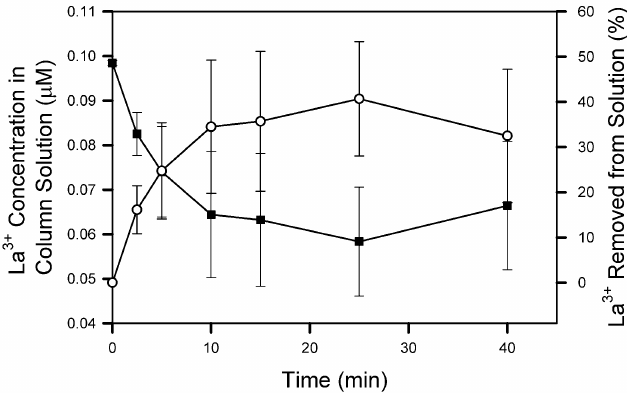
Figure 7. La 3+ column solution concentration ( (cid:4) ) and percent metal removed from solution ( ○ ) during flotation of La 3+ . The 40 min data were collected after sparging ceased and column foam collapsed. Symbols represent mean and standard deviation values from triplicate columns (n = 3).